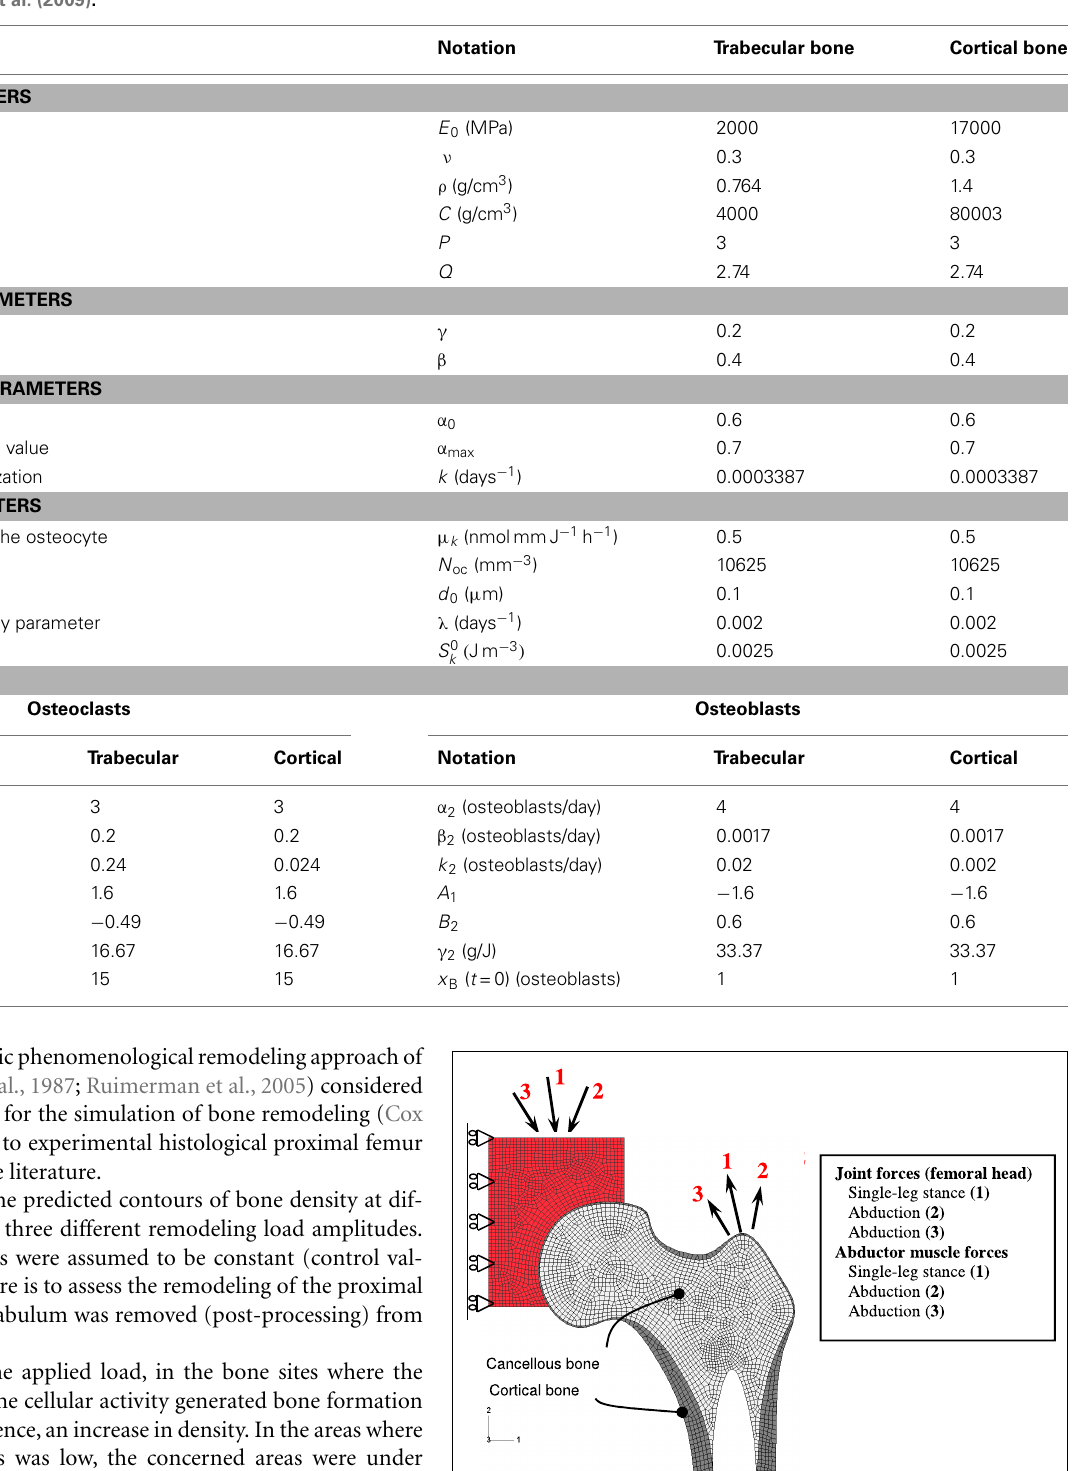
Table 1 | Material properties for bone used for the remodeling simulation from Mullender and Huiskes (1995), Hernandez et al. (2001), Komarova et al. (2003), Hambli et al. (2009).